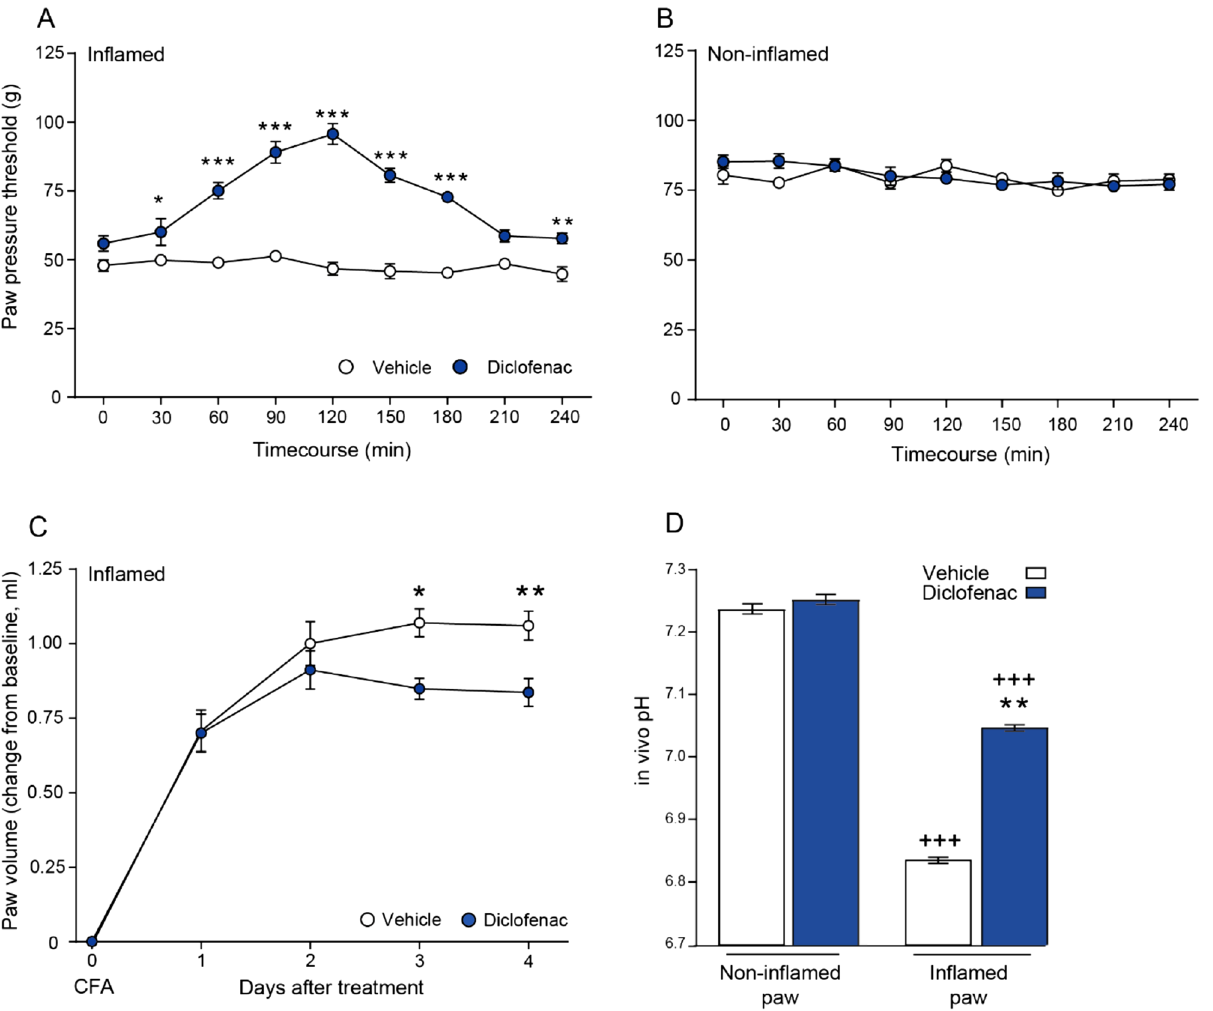
Figure 2. Effects of subcutaneous (s.c.) diclofenac on nociceptive responses, inflammation and tissue pH. The paw pressure threshold (PPT) values after daily s.c. diclofenac (DCF; 20 mg/kg) injections in inflamed ( A ) and in contralateral non-inflamed ( B ) hindpaws, assessed at 4 days after intraplantar (i.pl.) complete Freund’s adjuvant (CFA) inoculation before (0) and up to 240 min after the last DCF injection. * P < 0.05, ** P < 0.01, *** P < 0.001 DCF versus vehicle, two-way RM ANOVA and Bonferroni tests. ( C ) Decrease of inflamed paw volume after daily s.c. DCF (20 mg/kg) injection measured for 4 days after i.pl. CFA inoculation after each DCF injection. * P < 0.05, ** P < 0.01 DCF versus vehicle, two-way RM ANOVA and Bonferroni test. ( D ) pH values in inflamed paw tissue after DCF treatment (20 mg/kg s.c.) at 4 days after i.pl. CFA inoculation. ** P < 0.01 DCF versus vehicle, two-tailed unpaired t-test; +++ P < 0.001 inflamed versus non-inflamed paw, two-tailed paired t-test. Data show means ± SEM (n = 8 rats per